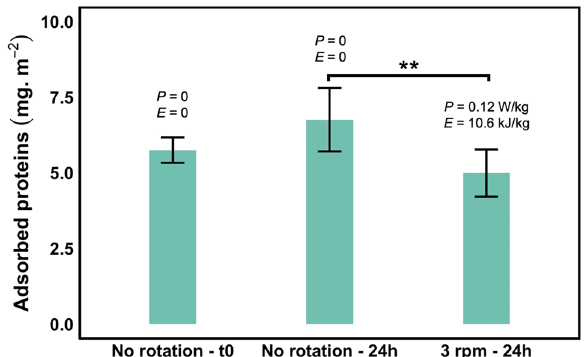
Figure 6. Amount of adsorbed proteins on PP tubes in mg/m 2 as a function of the rotational speed for YPE cell extracts. The power (P) and energy (E) are indicated for each condition. The adsorbed proteins were removed using 0.1% v/v sodium dodecyl sulfate (SDS) and the amount of proteins measured by UV